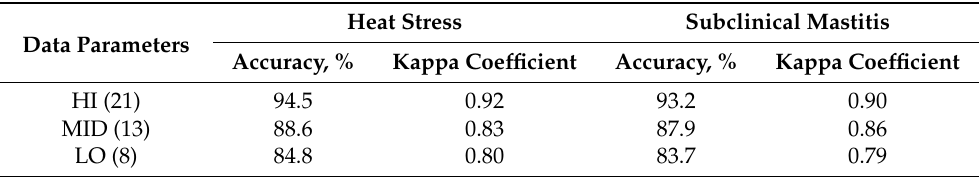
Table 2. The overall accuracy and Kappa coefficient of using the data-mining hub with a different number of parameters: HI (21 parameters), MID (13 parameters), and LO (8 parameters).